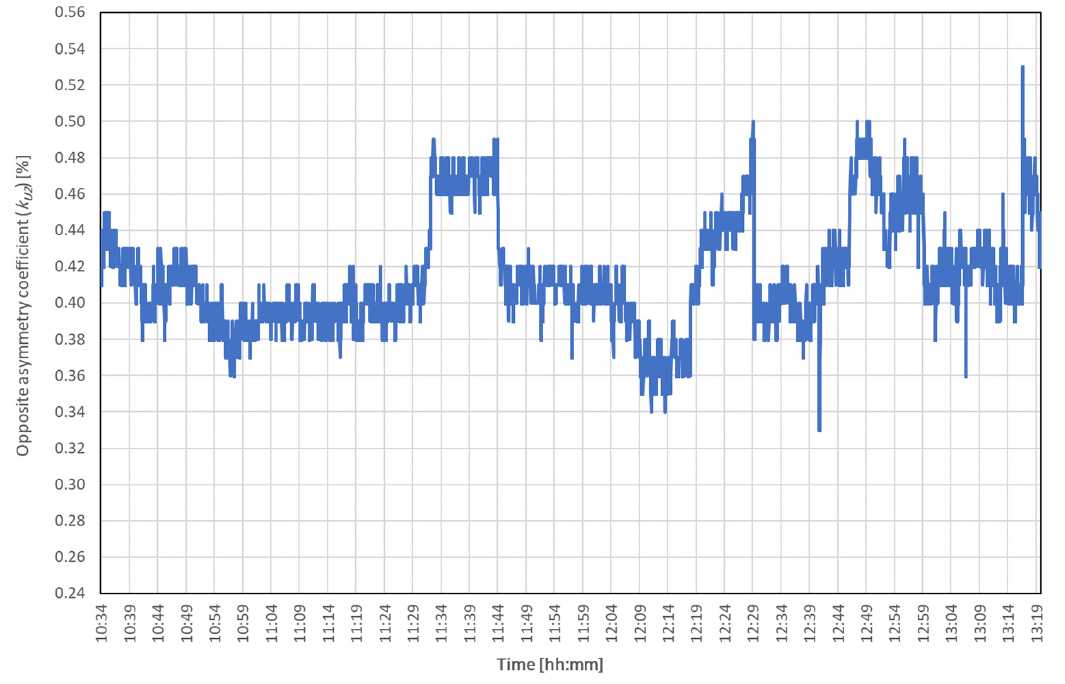
Figure 8. Time course of the value of the opposite asymmetry coefficient ( k U2 ) at the wind power plant connection point.